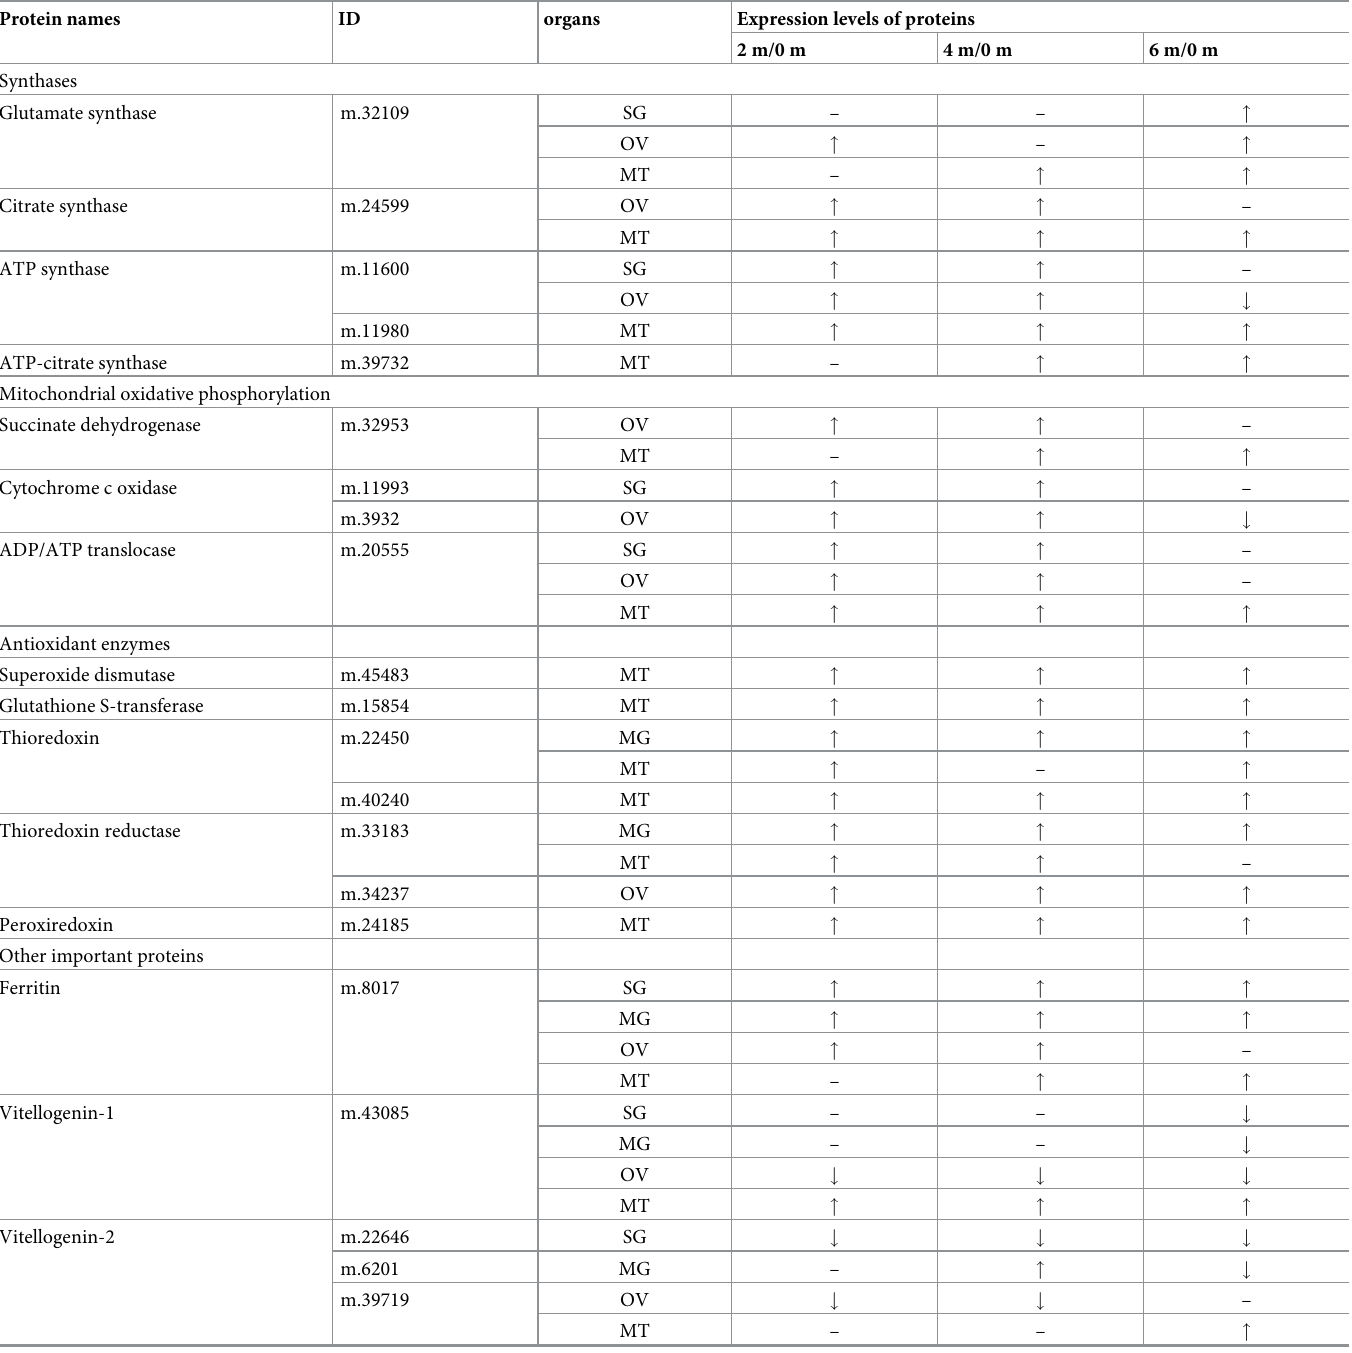
Table 1. Selected differentially expressed proteins during starvation in H . longicornis